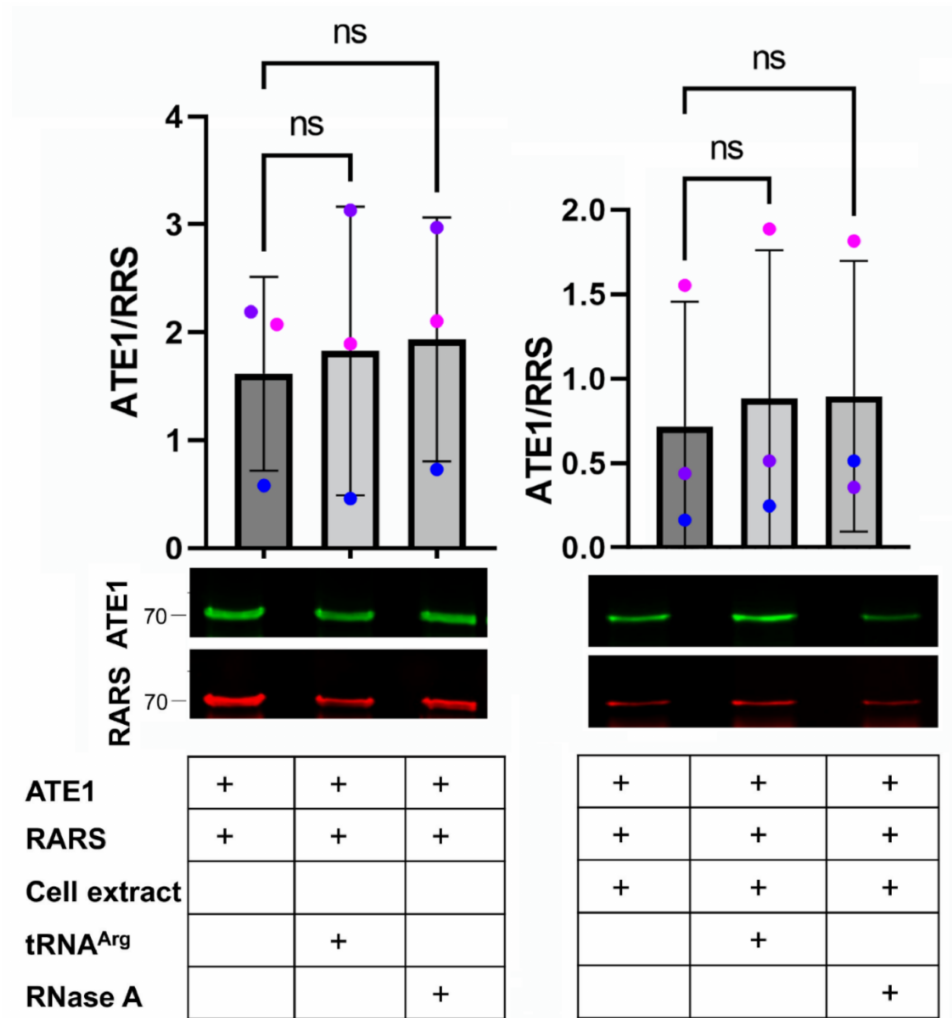
Figure 4. The ATE1–RARS interaction does not depend on tRNA. Quantification (top) and represen- tative immunoblots (bottom) of purified ATE1 and RARS pulldowns in the presence and absence of tRNA, RNase A and cell extract, as indicated in the table on the bottom under each lane and bar (+ represents addition of each component in each line). Error bars represent SD; n = 3 independent pulldowns. ns, not significant, one-way